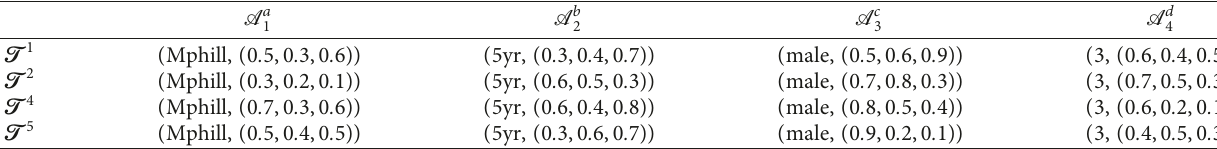
Table 6: The tabular form of the above